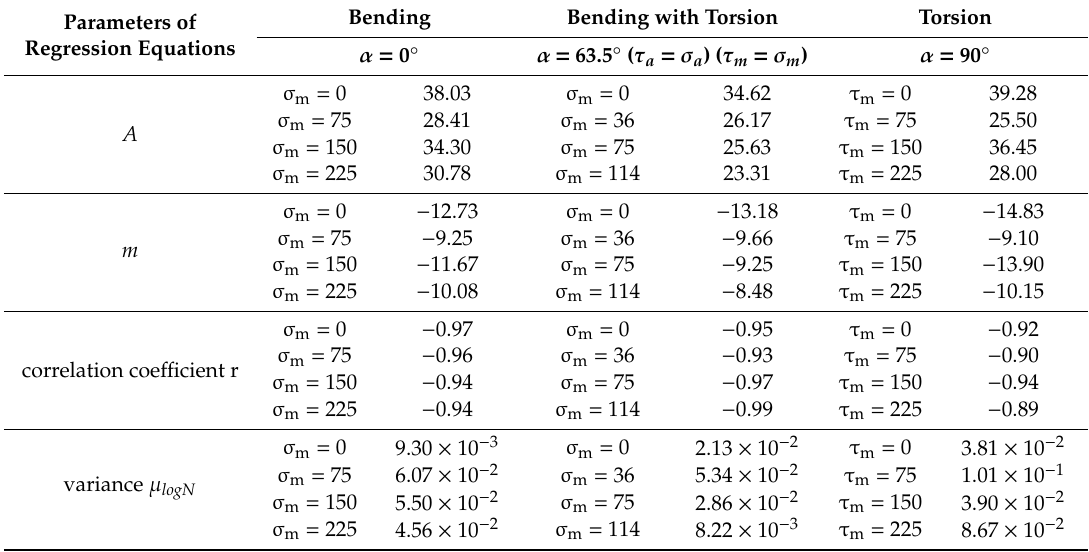
Table 3. Parameters of regression equations describing fatigue life of smooth specimens. Parameters